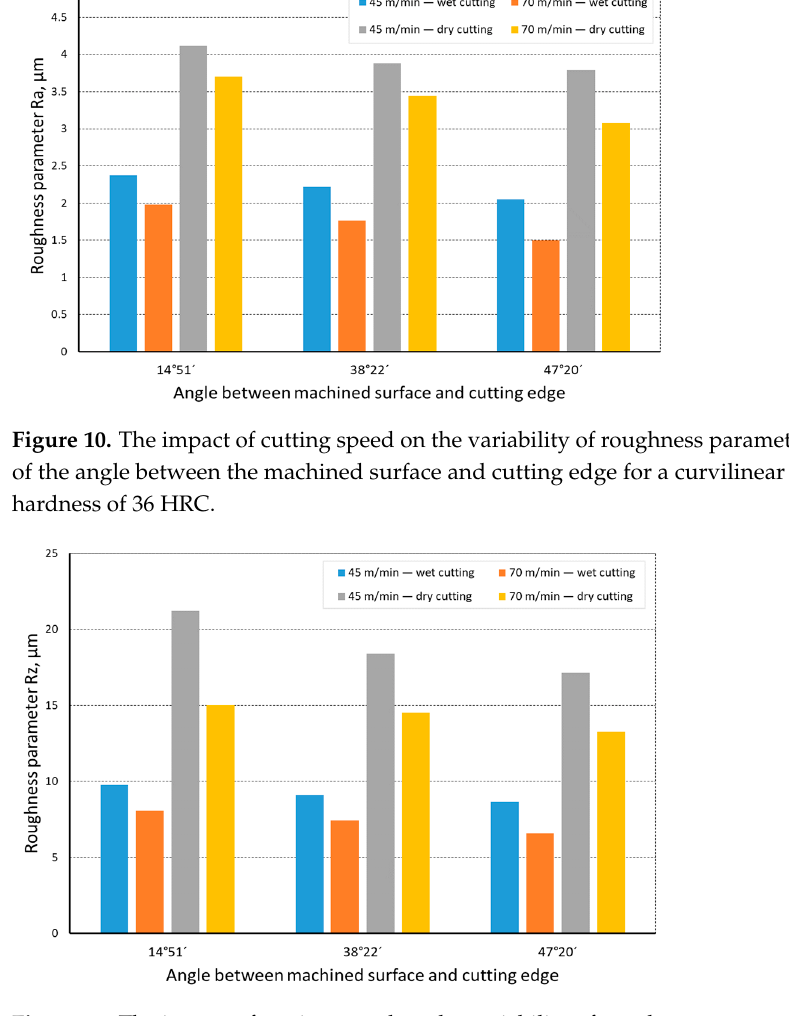
Figure 11. The impact of cutting speed on the variability of roughness parameter Rz in the function of the angle between the machined surface and cutting edge for a curvilinear track and a material hardness of 36 HRC.